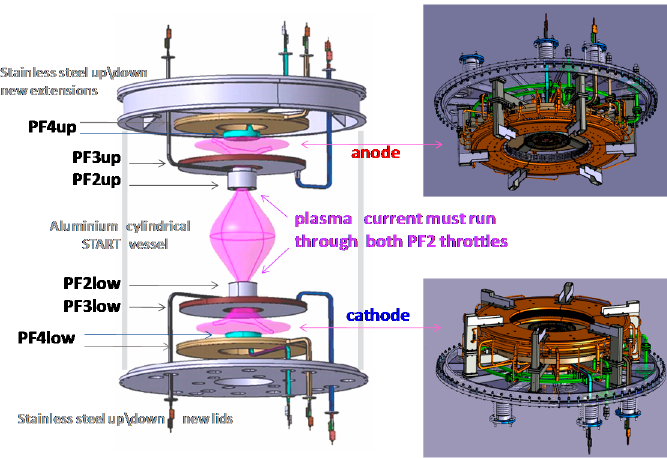
Figure 7. The eight PFCs in series inside the vacuum vessel.